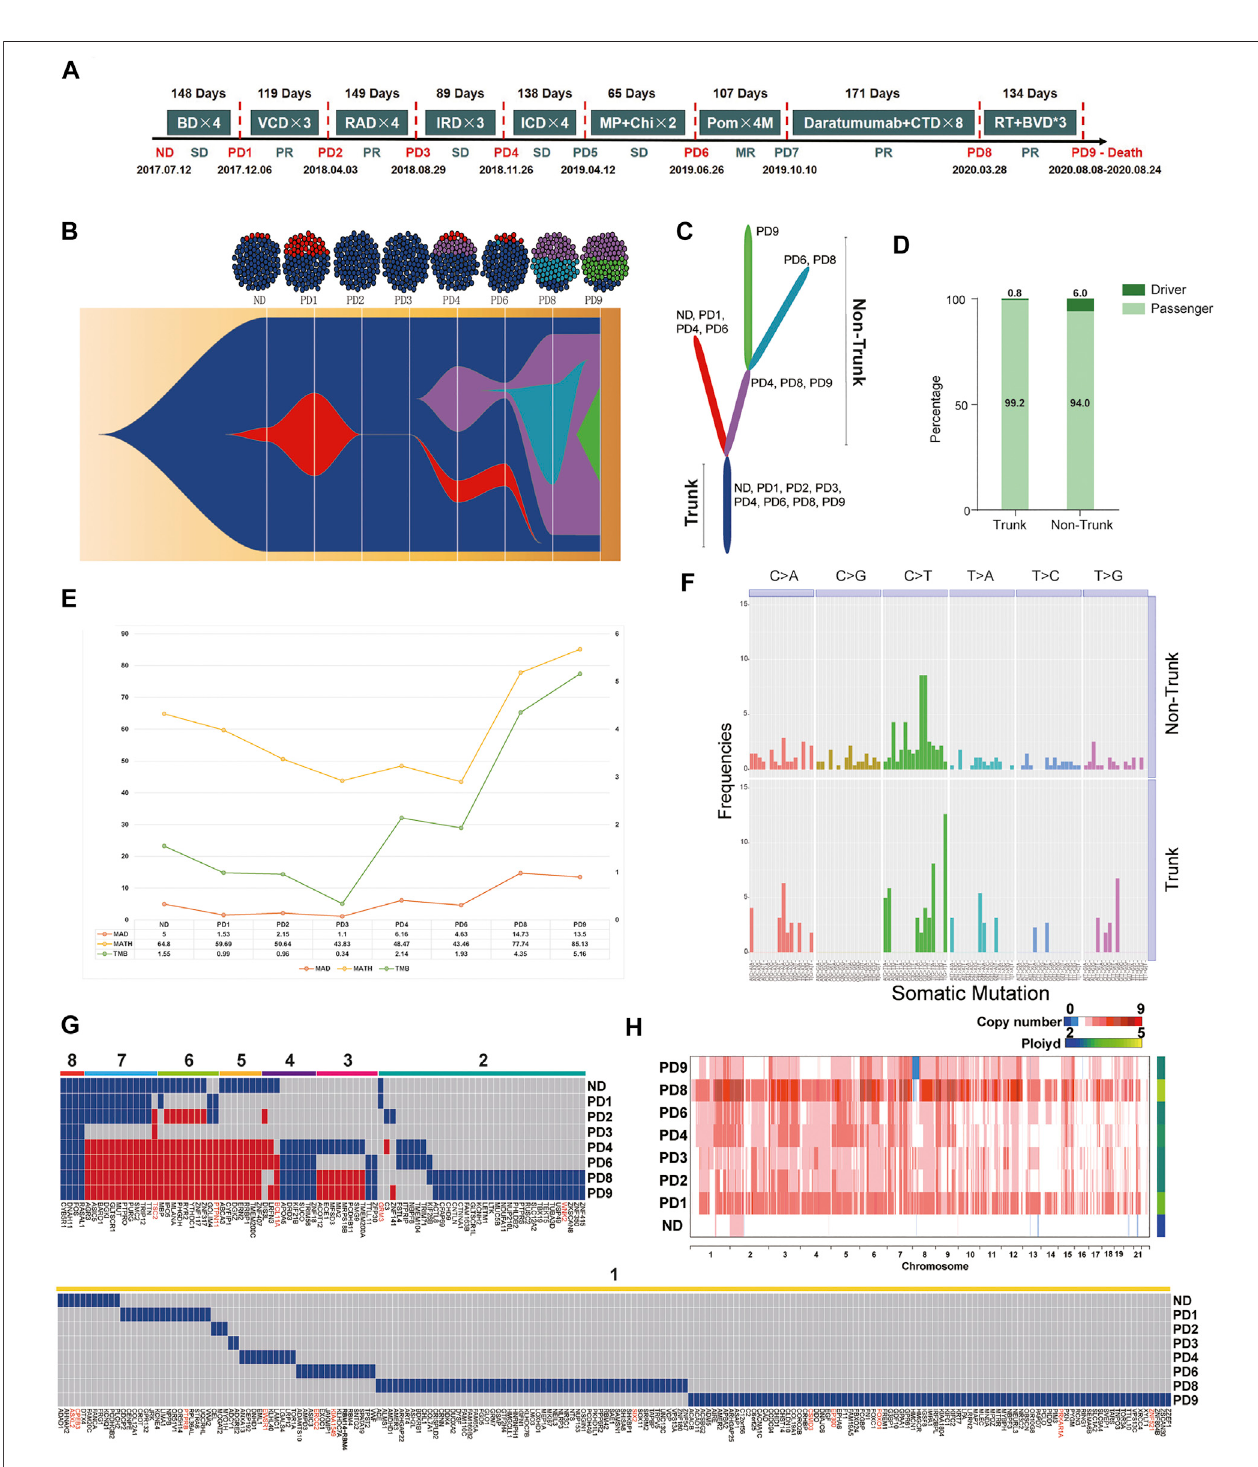
FIGURE 1 | (A) Treatment timeline for P1: After diagnosis with active MM (2017.7.12), P1 received Bortezomib/Dexamethasone (BD) as the primary therapy. After four cycles of BD, P1 suffered the fi rst PD (PD1, day 1 – 148, TTP (cid:1) 148 days). The second line therapy were Bortezomib/Cyclophosphamide/Dexamethasone (VCD). AfterthreecyclesofVCD,P1sufferedthesecondPD(PD2,day148 – 266,TTP (cid:1) 119 days).Lenalidomide/Adriamycin/Dexamethasone(RAD)wereselectedasthethird line therapy regimen. The third PD (PD3, day 266 – 414, TTP (cid:1) 149 days) occurred after three cycles of RAD. After three cycles of the fourth-line therapy, Ixazomib/ Lenalidomide/Dexamethasone(IRD), P1suffered thefourth PD (PD4, day 414 – 503, TTP (cid:1) 89 days). Ixazomib/Cyclophosphamide/Dexamethasone (ICD) were the fi fth- line therapy regimen. After four cycles of ICD, P1 had a clinical relapse (PD5, day 503 – 640, TTP (cid:1) 138 days). The therapy further changed to Melphalan/Prednisone/